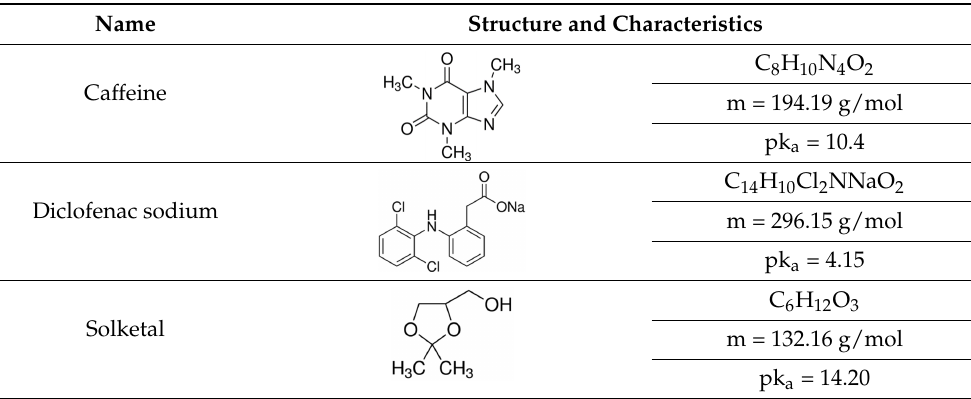
Table 1. Chemical structures/physicochemical characteristics of the adsorbates.